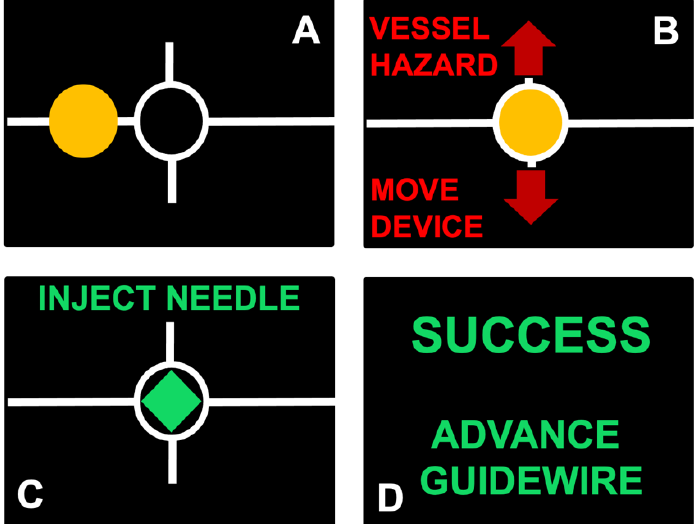
Figure 3. Selected views from user guidance display, ( A ) dot turns yellow as device approaches proper vessel position, ( B ) presence of hazards causes display to direct user to reposition device cranially or caudally, ( C ) dot turns green to indicate readiness for needle insertion, ( D ) automatic confirmation of needle insertion is displayed.